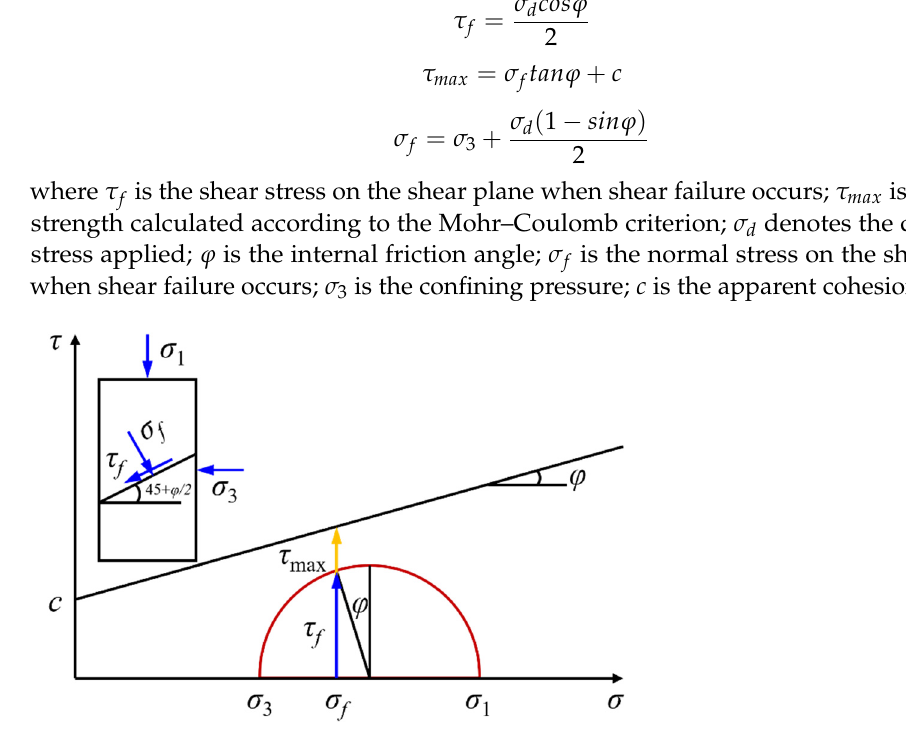
Figure 5. Illustration of the definition of shear stress ratio (SSR).